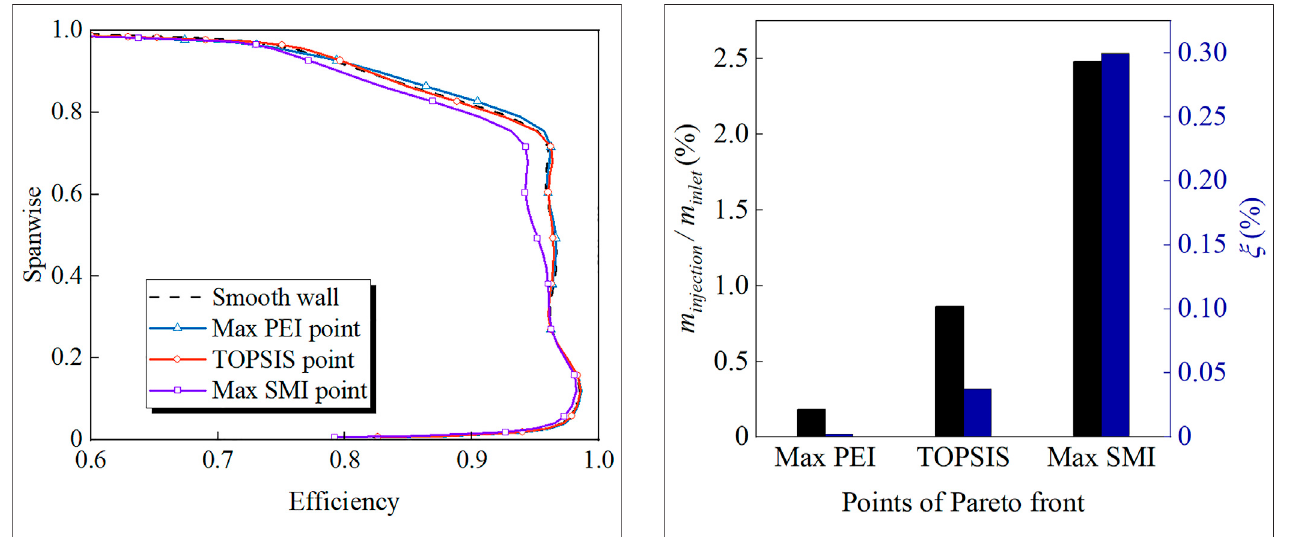
FIGURE 12 | Spanwise distribution of pitch averaged adiabatic ef fi ciency at the rotor outlet.